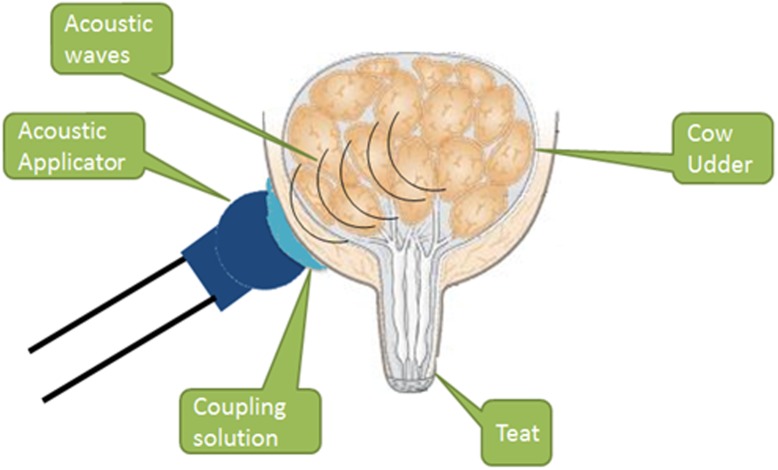
Schematic action of the acoustic pulse.A scheme of the new technological device for cow treatments producing high powered acoustic pulses distributed on a large treatment area with deep penetration via the applicator.